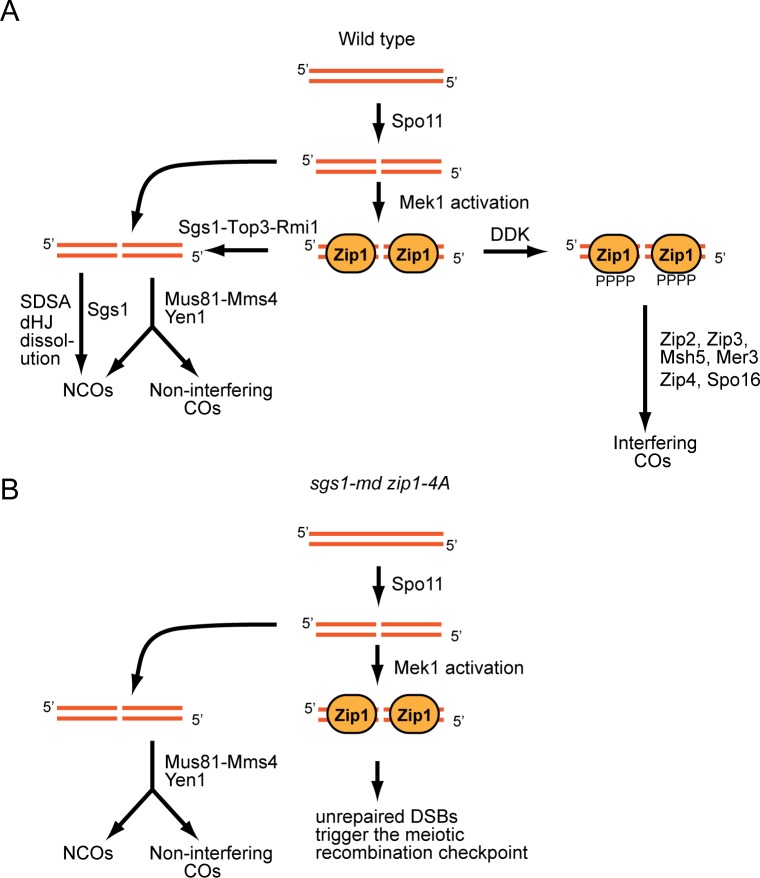
Model for the role of Zip1 4S phosphorylation is regulating COs.(A) Wild-type cells. STR stands for Sgs1-Top3-Rmi1. (B) sgs1-md cells.